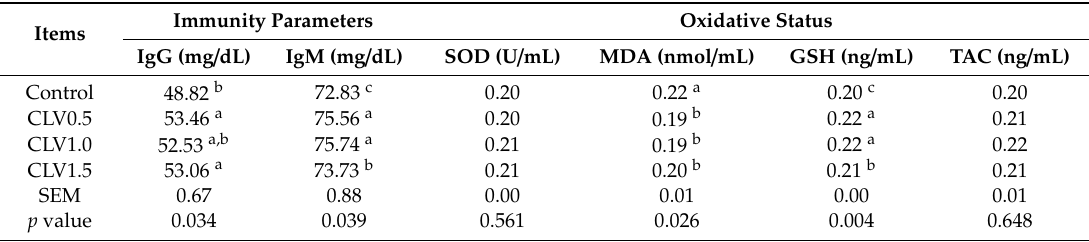
Table 7. Immunity and oxidative status of growing NZW rabbits as a ff ected by dietary treatments at 13 weeks of